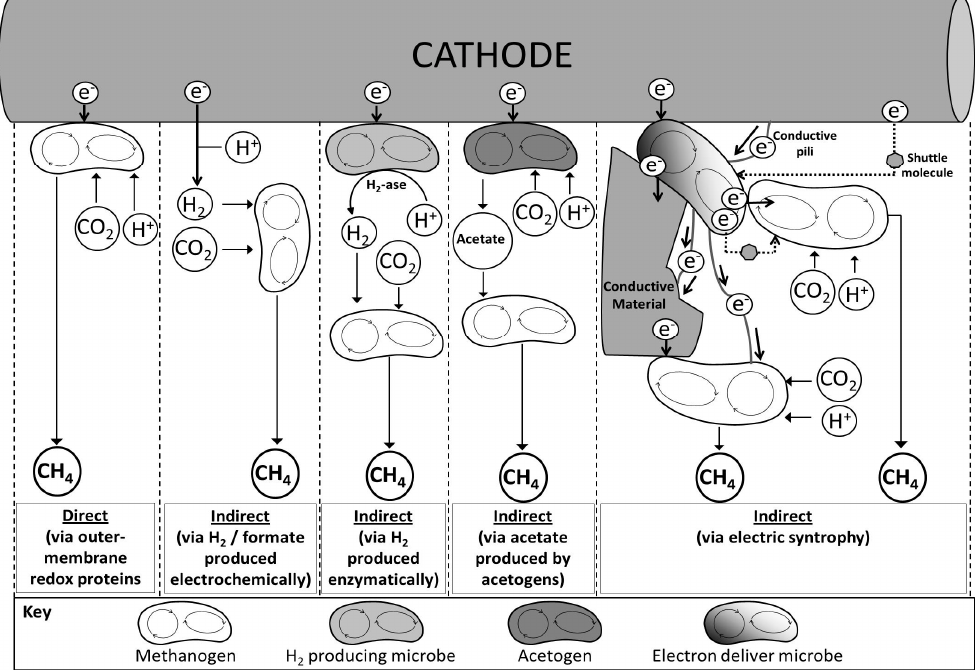
Figure 4. Proposed electron transfer mechanisms within the biocathode compartment. Even though H 2 is the only intermediate molecule (bio)electrochemically produced on the surface of the electrode shown in the figure, formate or other molecules must be also considered to play the same role as electron carrier. Sizes of the circles do not correspond to any proportions.